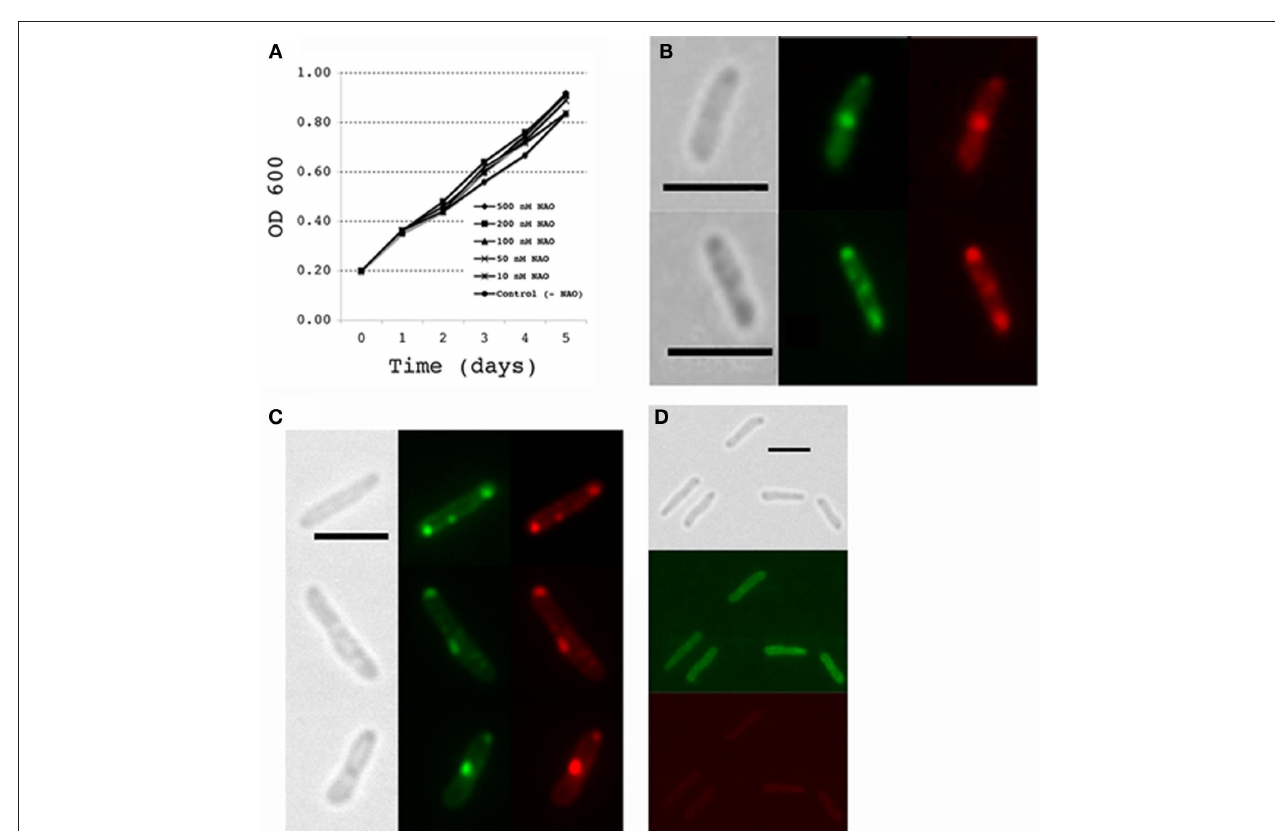
staining of monoacidic phospholipids and red fluorescence images represent NAO staining in regions where cardiolipin is present. (C,D) NAO staining of M. smegmatis during active growth and stationary phase, respectively. Active cultures growing at an OD600 of 0.2 were supplemented with 100 nM NAO and incubated for 2 h at 37 ° C. Mycobacterium smegmatis cultures grown for overnight to an OD of 3.5 are referred to as stationary phase cells. NAO was 600 added and incubated for 2 h at 37 ° C; live cells were removed from the cultures and directly observed by fluorescence microscopy. All images were taken at 100 × magnification with scale bars representing 3